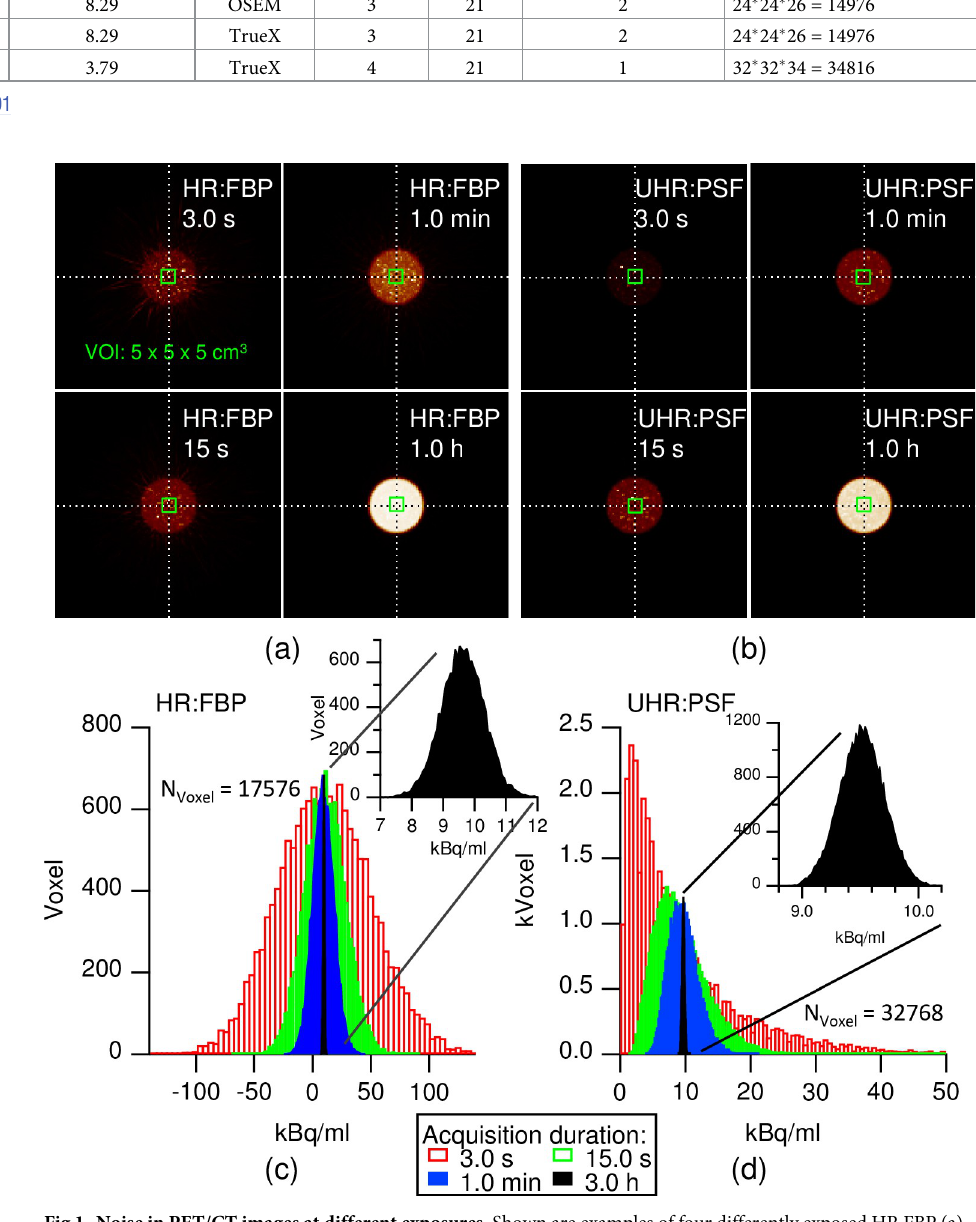
Fig 1. Noise in PET/CT images at different exposures. Shown are examples of four differently exposed HR FBP (a) and UHR PSF (b) images, using the daily QA phantom. Images are maximum intensity projections (MIPs) in the axial direction of the PET system with black set to naught and white set to the maximal intensity found in the PET image. The green rectangle marks the VOI, where all the calculations were performed. The associated noise histograms of the HR FBP (c) and UHR PSF (d) measurements are depicted below, showing the measured AC distribution in the VOI after four different acquisition durations. N voxel denotes the number of analyzed voxels in the VOI. Black insets are magnified histograms of the longest acquisition. Color legend of acquisition durations applies to both (c) and (d).